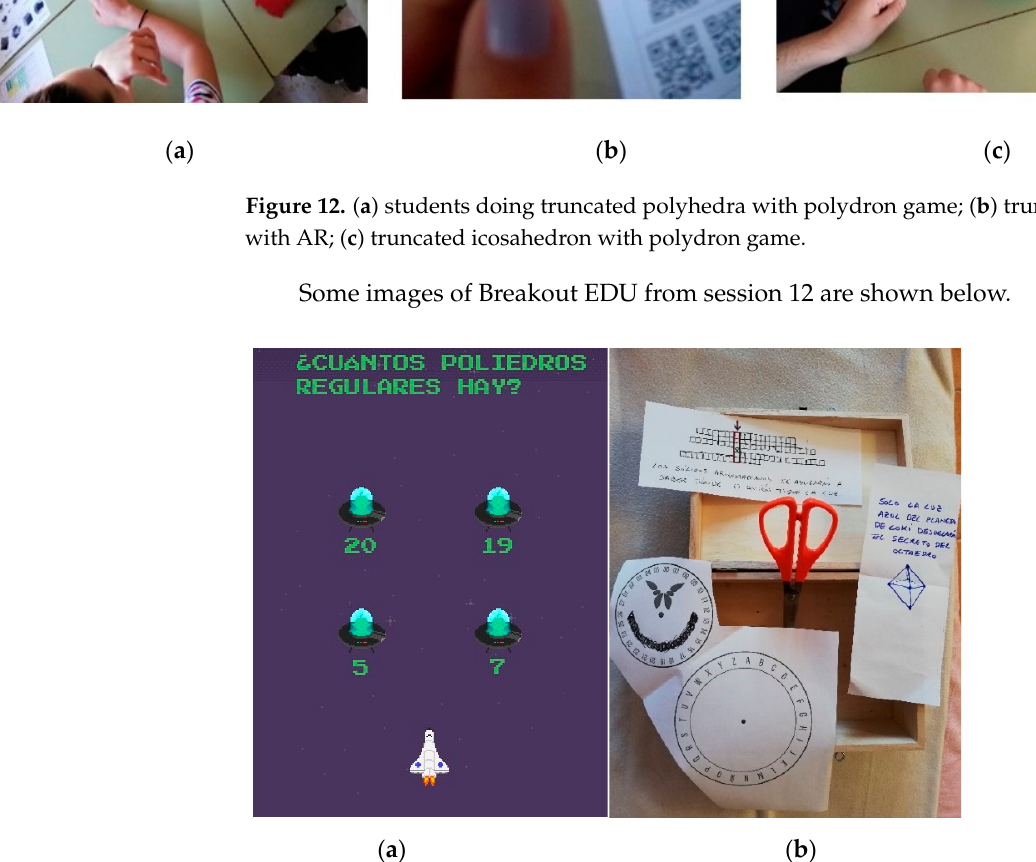
Figure 13. ( a ) capture of videogame quiz in Genially; ( b ) elements for Breakout EDU.